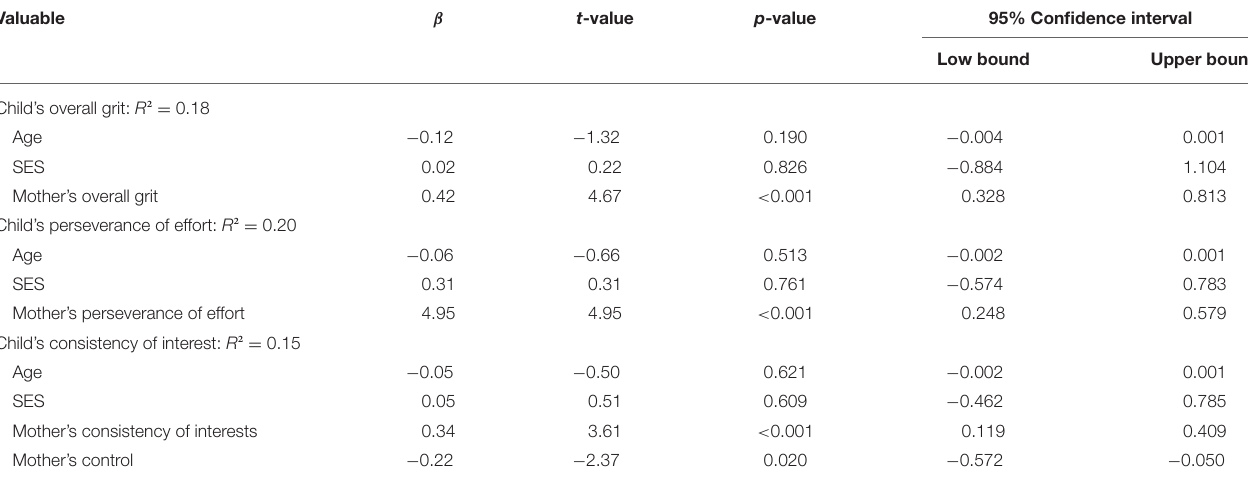
Low bound Upper bound